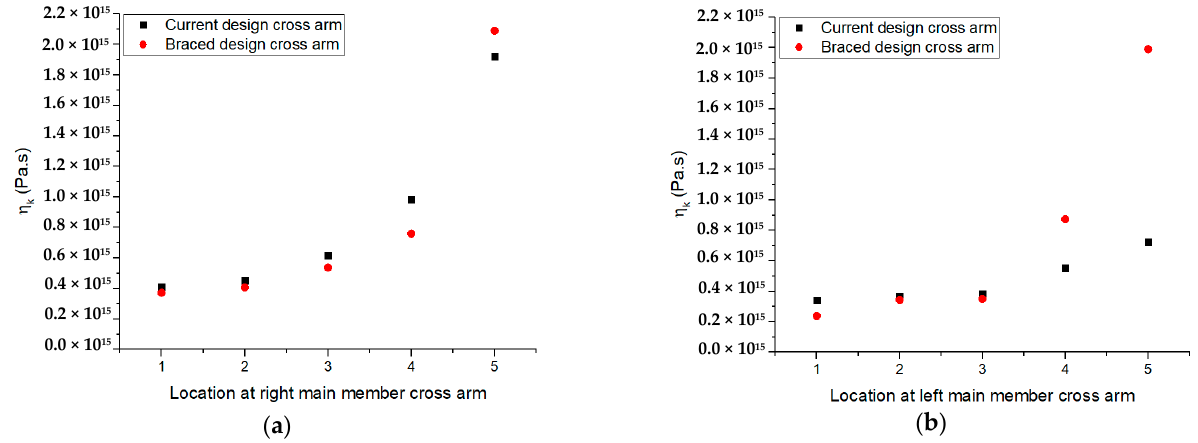
Figure 12. η k parameter for current and braced wooden cross-arms: ( a ) right; ( b ) left main